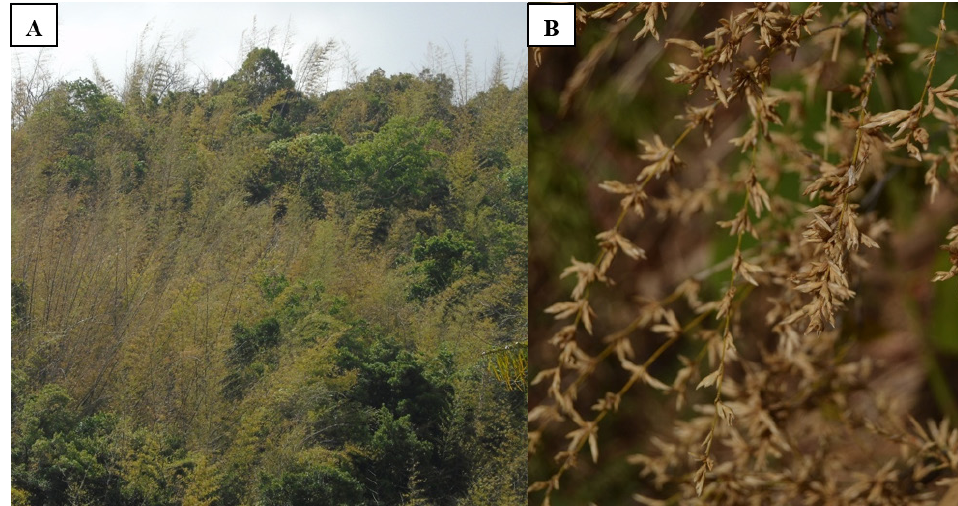
Figure 2: Bamboos play an important component in both wet and dry zone forests in Sri Lanka. A: the spread of native Bambusa bambos in moist evergreen forests in Sri Lanka altering the forest structure and composition; B: flowering of B. bambos .